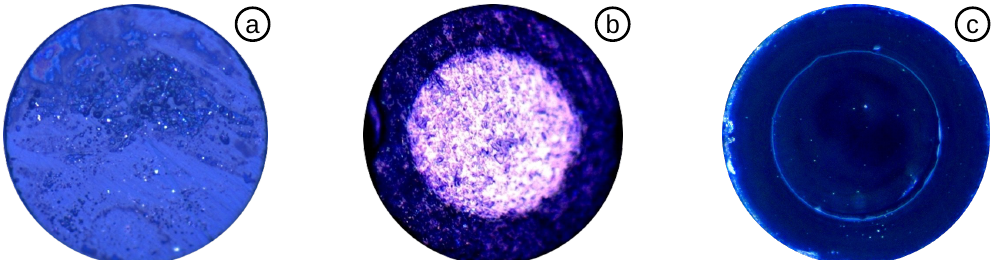
Figure 6. Top view of: ( a ) cut MMF without polishing; ( b ) MMF polished down to 12–20 µ m; ( c ) MMF polished down to 4–8 µ m, captured by a Zeiss